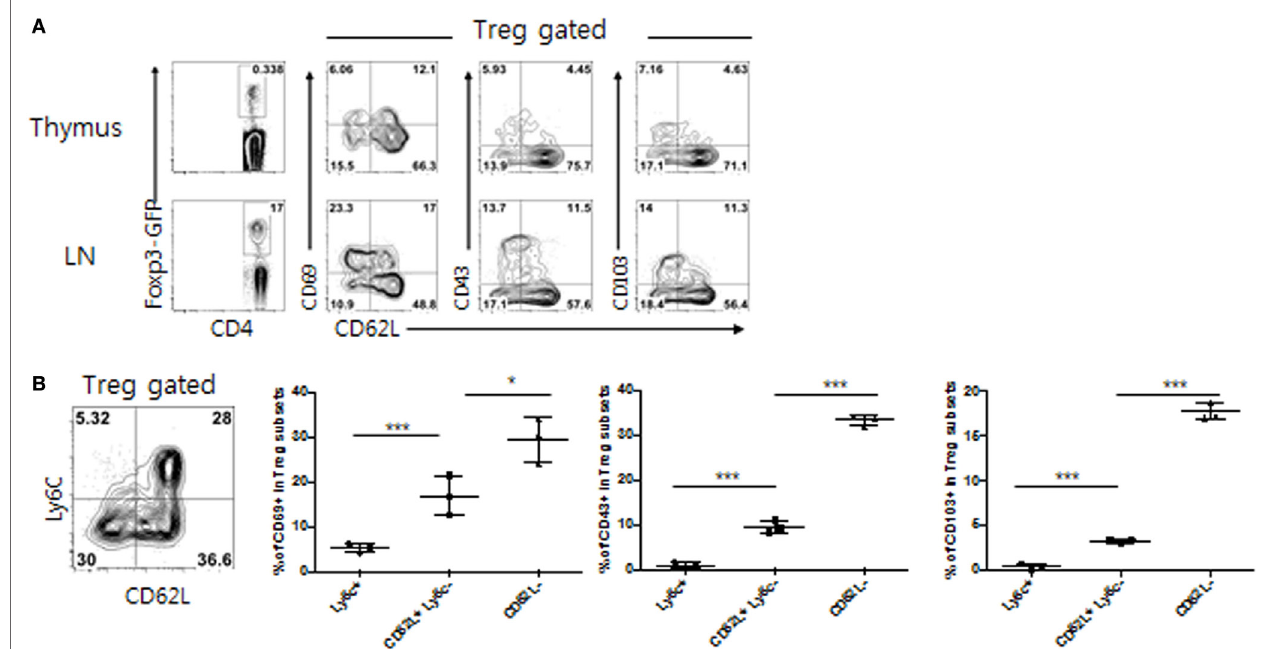
FigUre 1 | Phenotypic heterogeneity of peripheral T regulatory (Treg) populations. (a) Lymphocytes from thymus or peripheral lymph nodes (PLN) from Foxp3-eGFP mice were analyzed for indicated marker expression. (B) Treg subsets from PLN of Foxp3-eGFP mice were analyzed for CD69, CD103, and CD43 expression. The data are representative of three experiments comprising three mice per group. * p < 0.05, ** p < 0.01, and *** p <